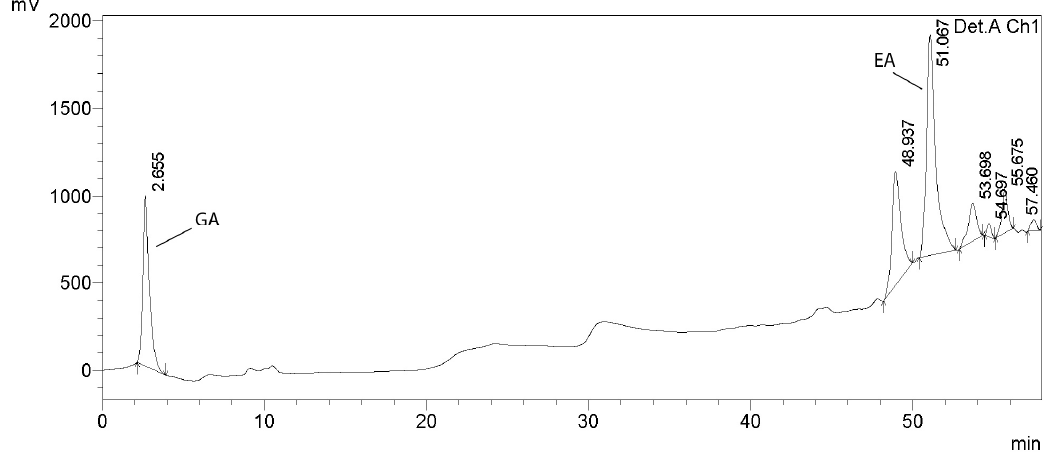
Figure 1. HPLC chromatogram for Quercus robur L. extract (GA—gallic acid, EA—ellagic acid).